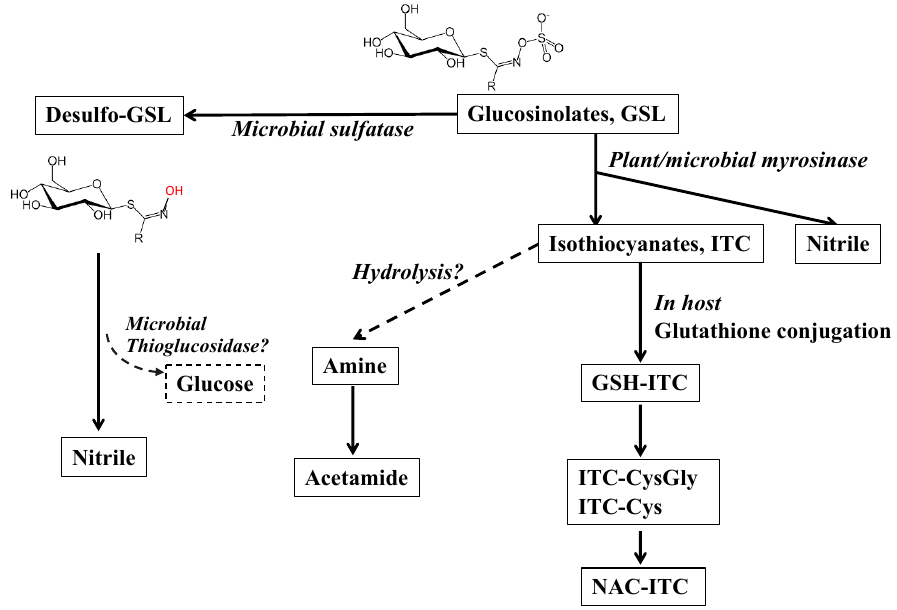
Figure 2. Alternative pathways of microbial metabolism of glucosinolates (GSL). Plant/microbial myrosinase hydrolyzes GSL to form isothiocyanates (ITC) and/or nitrile. ITCs can then be conjugated with glutathione (GSH-ITC) in the host. This conjugate then enters the circulation, travelling to the liver where it is further metabolized through the mercapturic acid pathway to form ITC conjugates of cysteinylglycine (CysGly), and cysteine (Cys). A further metabolite, N-Acetylcysteine (NAC), is formed in the kidney [6]. Alternative pathways of ITCs were reported in flea beetle that ITCs can be hydrolyzed to form amine and acetamide [38,39]. An alternative pathway of GSL metabolism is to form desulfo-GSL by microbial sulfatase [38,39], possibly followed by removal of the glucose by microbial thioglucosidase, and result in a nitrile [44]. Dashed arrows are hypothesized pathways.